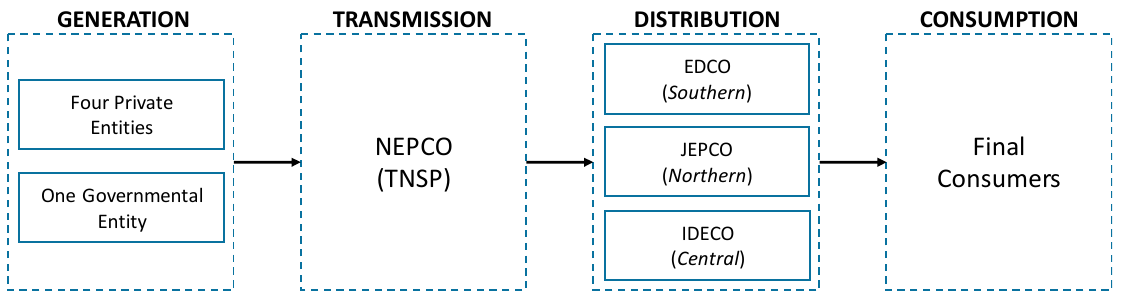
Figure 3. Jordanian market structure (single-buyer model) (simplified from [12]).